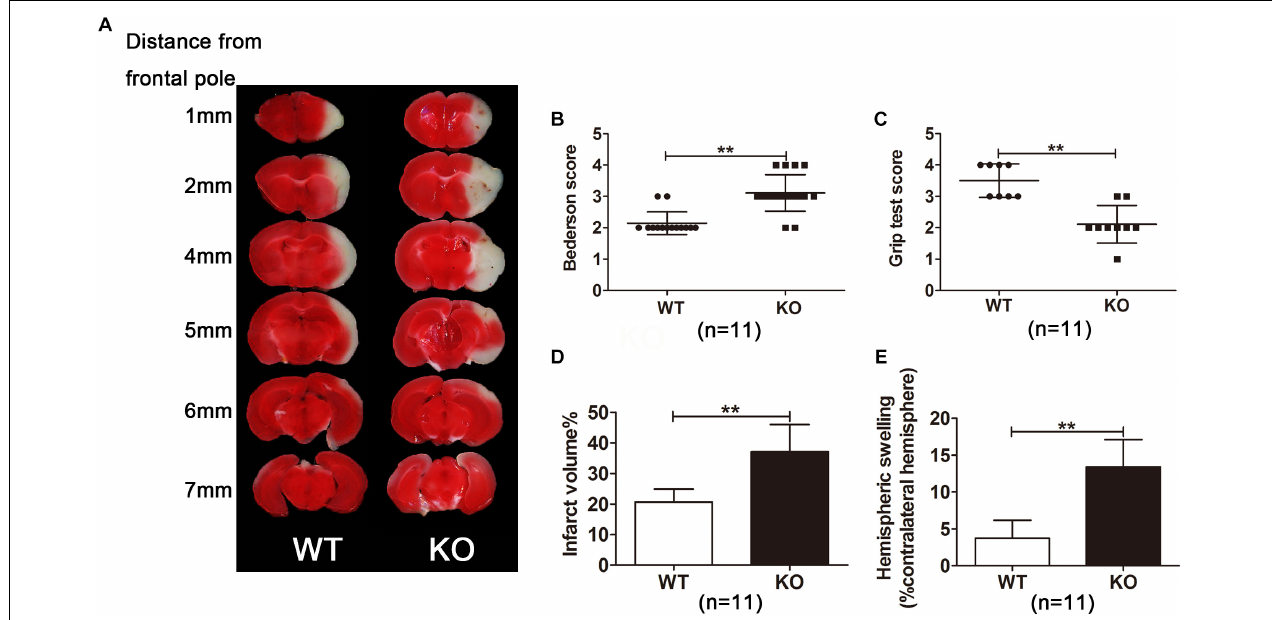
FIGURE 2 | Irak3 -null mice exhibited larger infarct volume and higher swelling index. (A) Representative images of TTC-stained brain slices from gene knockout and wild-type (WT) mice. (B, C) Neurologic deficit scores in WT and KO mice at 24 h after reperfusion. (D, E) Infarct size and swelling index were calculated with ImageJ software according to TTC staining. Data are presented as mean ± SD, n = 11 per group. ∗ P < 0.05, ∗∗ P < 0.01 vs. WT